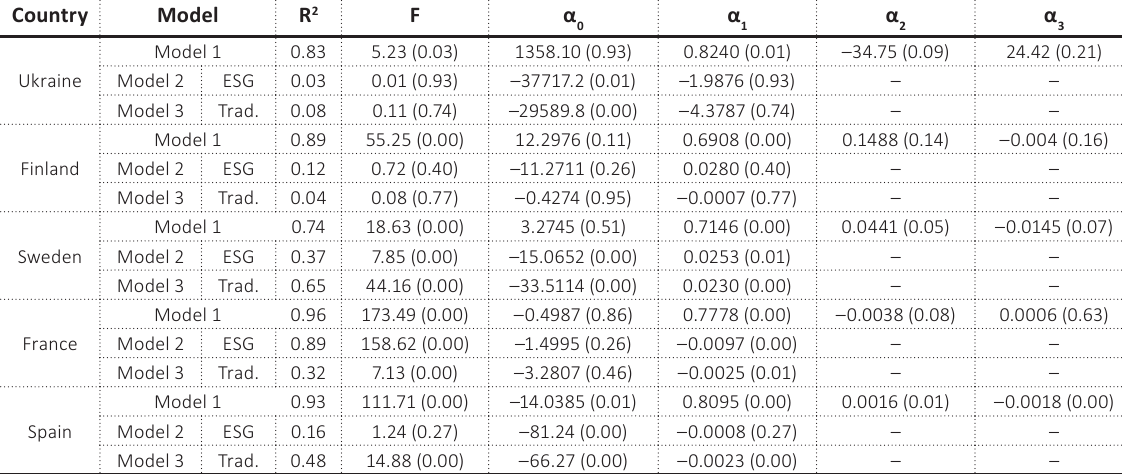
Table 8. Regression modeling for the indicator of a country’s investment